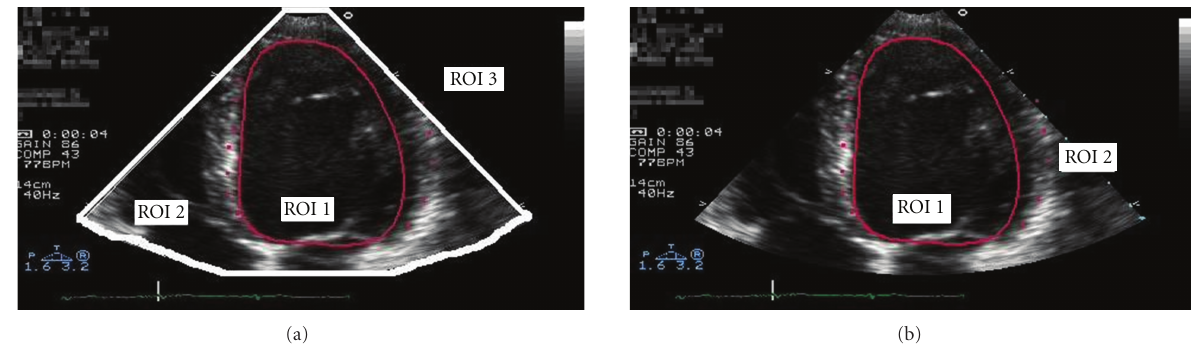
Figure 2: (a) Cardiac ultrasound image with ROIs (manually selected) highlighted. Three regions of interest, (b) Cardiac ultrasound image with ROIs highlighted. Two regions of interest.